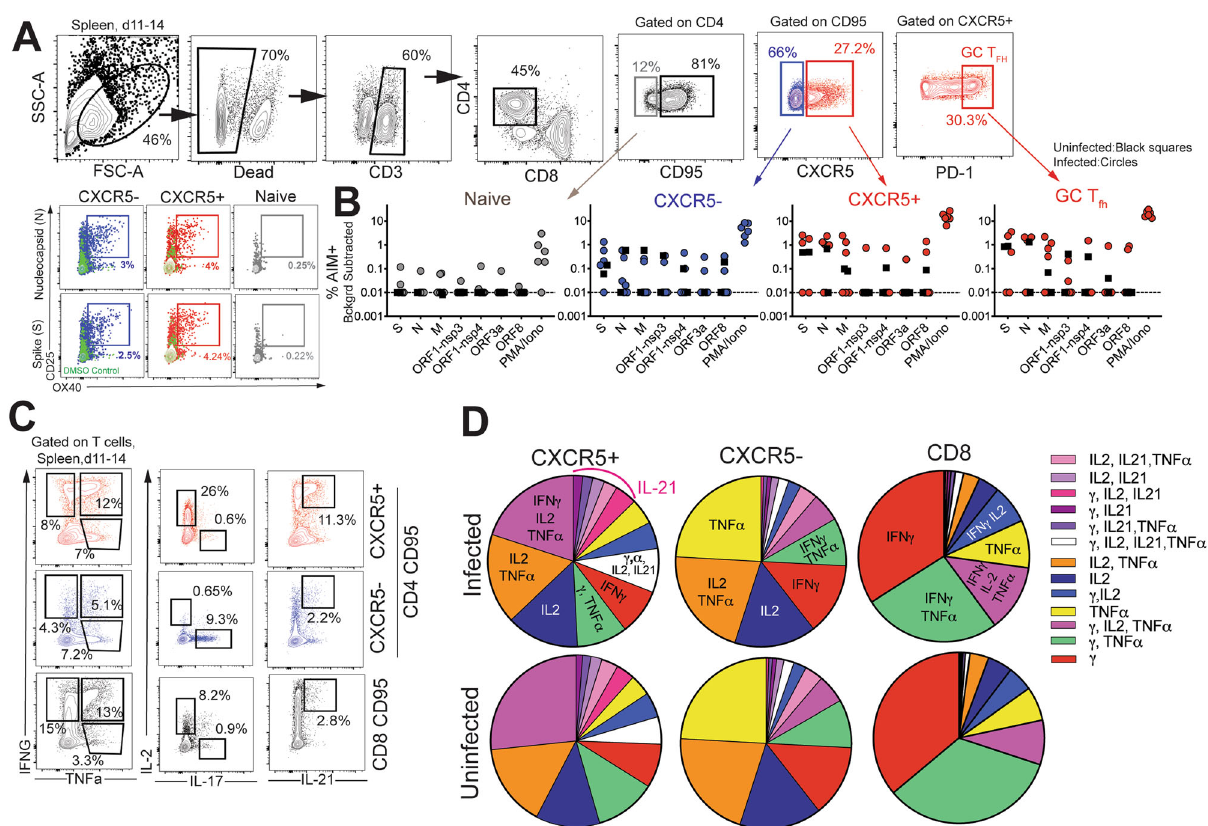
Fig. 4 CD4 T fh cells targeting spike (S) and nucleocapsid (N) are generated in lymphoid tissue following SARS-CoV-2 infection. A Representative gating strategy to identify SARS-CoV-2-speci fi c CD4 T cells following stimulation with peptide megapools; membrane (M), open reading frame non- structural proteins (ORF-nsp) and Phorbol 12-myristate 13-acetate (PMA)/Ionomycin (Iono) Fluorochromes used were CD3-A700, Dead-APC-Cy7, CD8- BV510, CD4-BV650, CD95-BUV737, CXCR5-PE, PD-1-Pe Cy7, CD25-APC, OX40-BV786, IFNG-Pe-Cy7, TNFa-A488, IL-17-BV421, IL-21-APC. B Scatter plot showing Activation-induced marker (AIM) + CD4 subsets. Dashed line represents undetectable responses assigned a value of 0.01% C Gating strategy to identify cytokine pro fi les (interferon (IFN) γ , interleukin (IL)-2, tumor necrosis factor (TNF)a, interleukin (IL)-17, interleukin (IL)-21) of CXCR5 + , CXCR5-, and CD8 + CD95 + T cells) in spleen following stimulation. D Pie chart shows T-cell